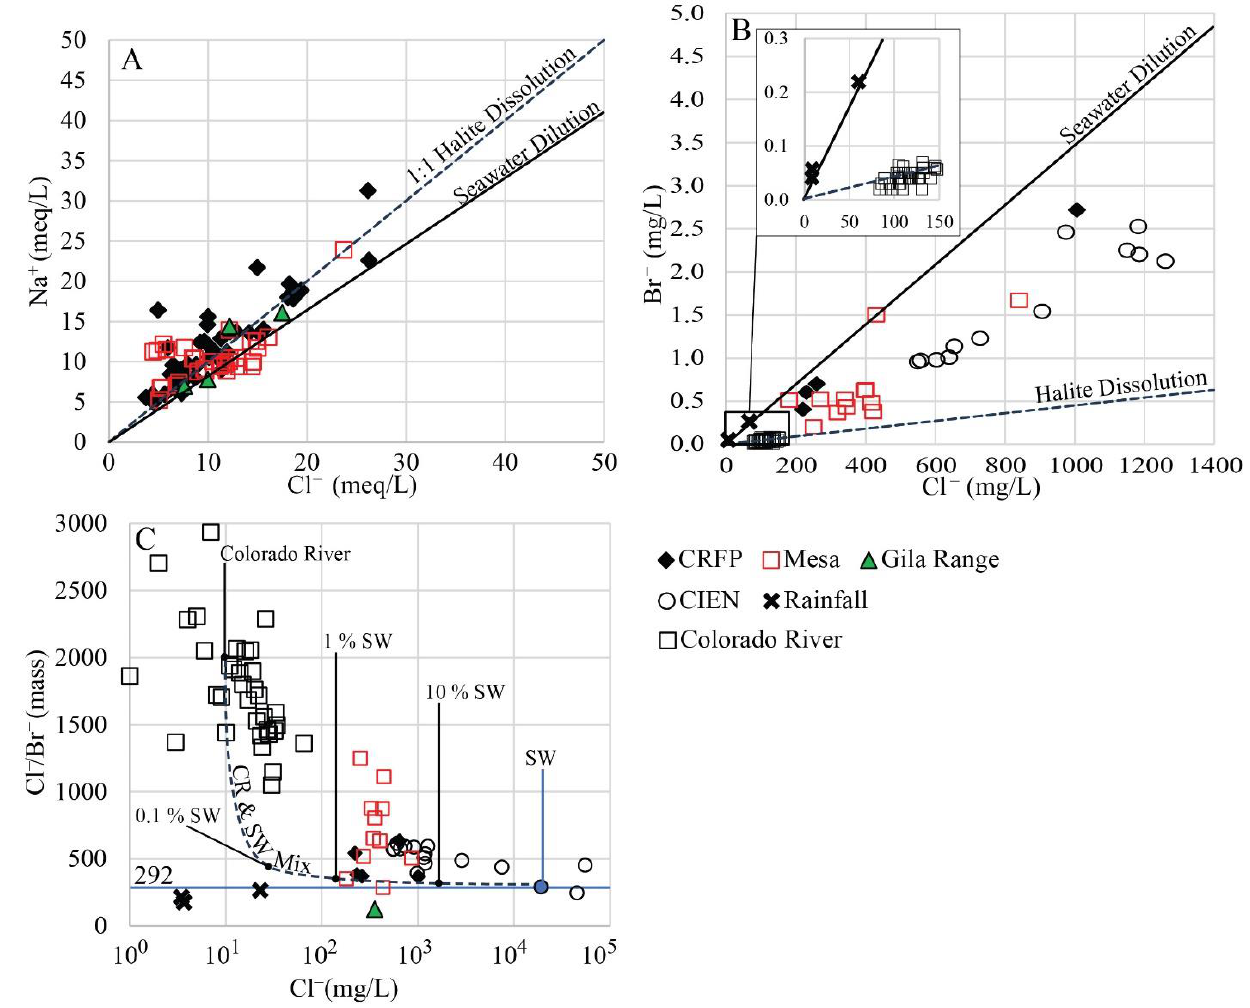
Figure 12. ( A ) Na + vs. Cl − (meq/L). Lines show 1:1 halite dissolution and seawater dilution trajectories. ( B ) Cl − (mg/L) vs. Br − (mg/L). Inset shows samples with low concentrations. ( C ) Cl − /Br − (mass) vs. Cl − (mg/L) with seawater/Colorado River water mixing trend. The horizontal line shows the seawater (SW) Cl/Br ratio [56]. Graphs include data for floodplain (CRFP), Mesa, Gila Range, surface water from the Ciénega (CIEN), local rainfall, and Colorado River. Colorado River data obtained from USGS Station 09404200. See text for further explanation.